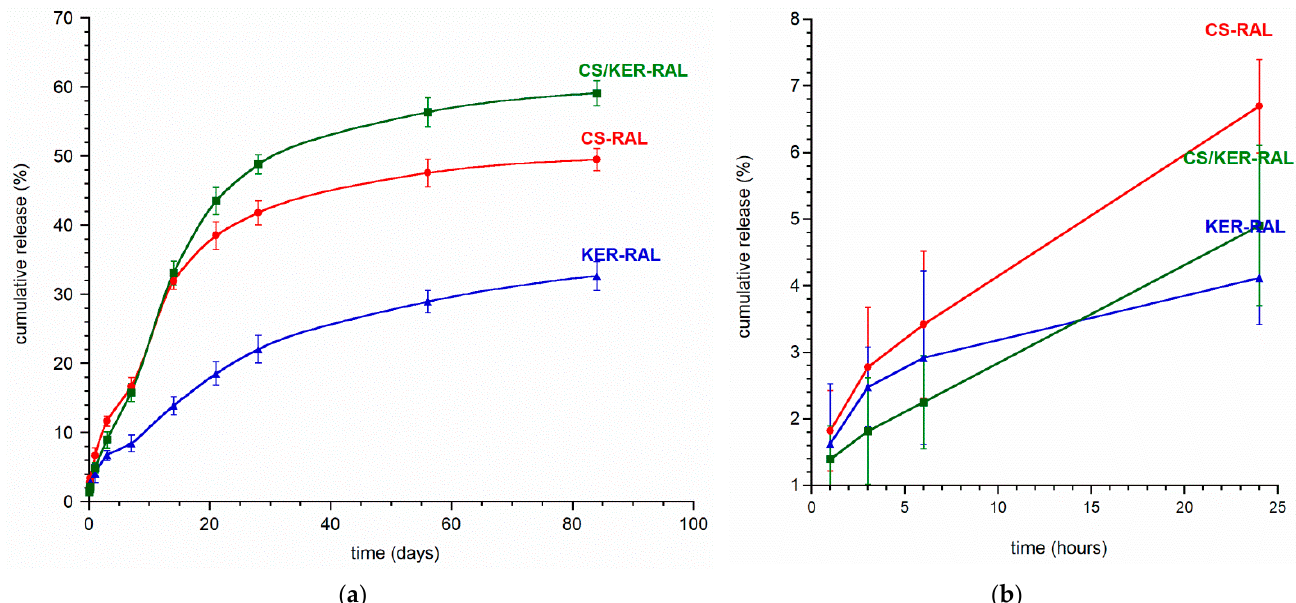
Figure 5. ( a ) Raloxifene hydrochloride release profile from CS-RAL, KER-RAL, and CS/KER-RAL over 12 weeks; ( b ) Raloxifene hydrochloride release profile from CS-RAL, KER-RAL, and CS/KER-RAL during the first 24 h.